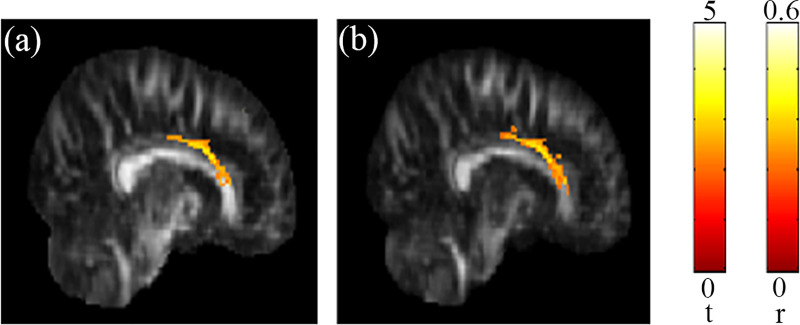
Association between the reading comprehension score and diffusion indices.Positive correlations between the reading comprehension score and (a) GFA and (b) NQA values were found in the corpus callosum. The color bar presents t-score and r (corrected p < 0.05).